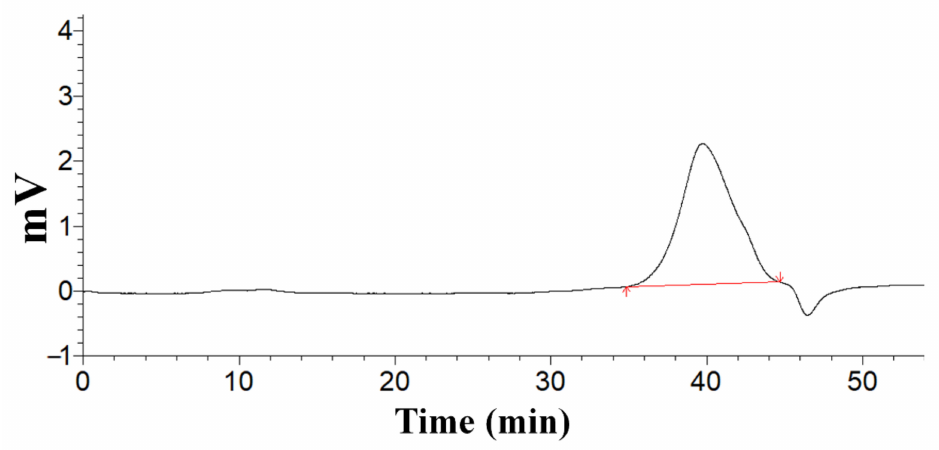
Figure 4. The homogeneity and molecular weight of